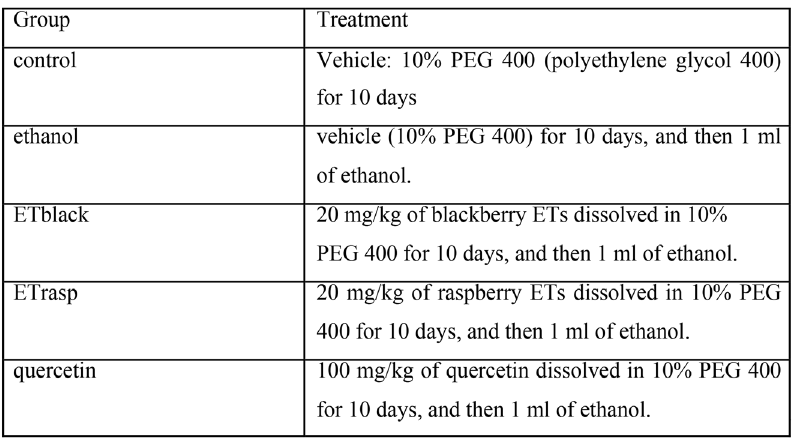
Figure 1. Experimental protocol for the in vivo study. Before the experiment, the animals were randomly divided in 5 groups (6 rats in each group) and treated intragastrically (i.g.) by gavage. The dose of ET enriched extracts was calculated on the basis of a daily consumption of 125 g of fresh fruit by a human healthy adult of 70 kg. The day before the induction of gastric lesions, rats were placed in individual metabolic cages and deprived of food, with free access to tap water for 20 h. The last administration of ETs extracts, quercetin or vehicle was given 120 min before ethanol treatment.